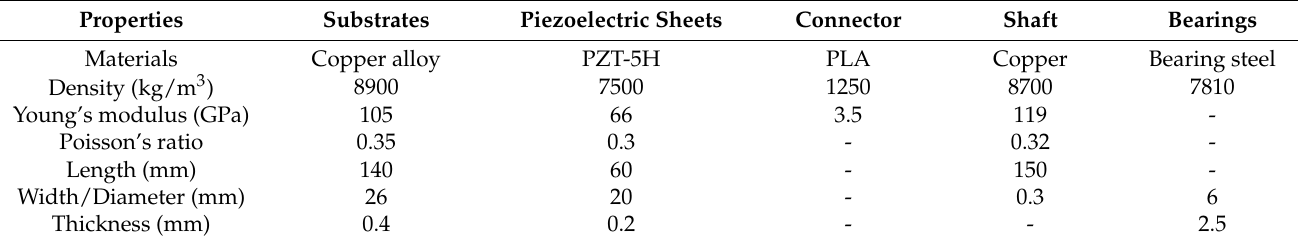
Figure 7. Enlarged view of FEH. Table 5. Materials and parameters of each part of the FEH.